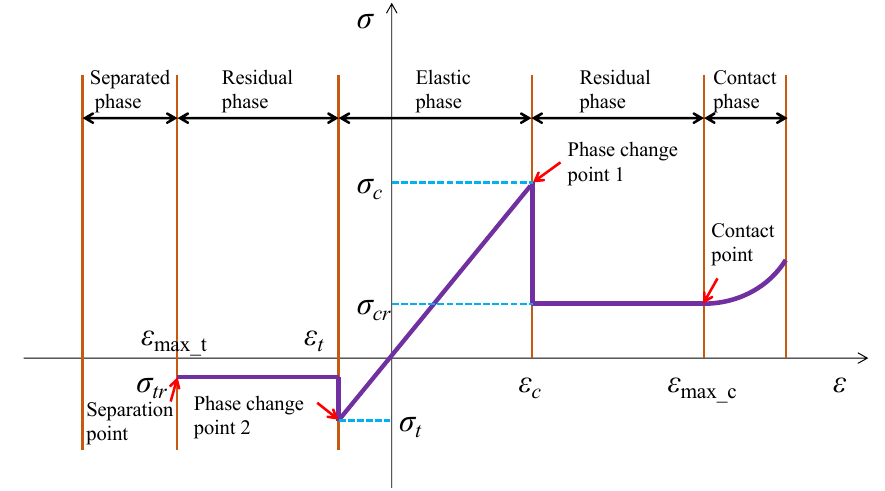
Figure 6. Phase transition of elements.